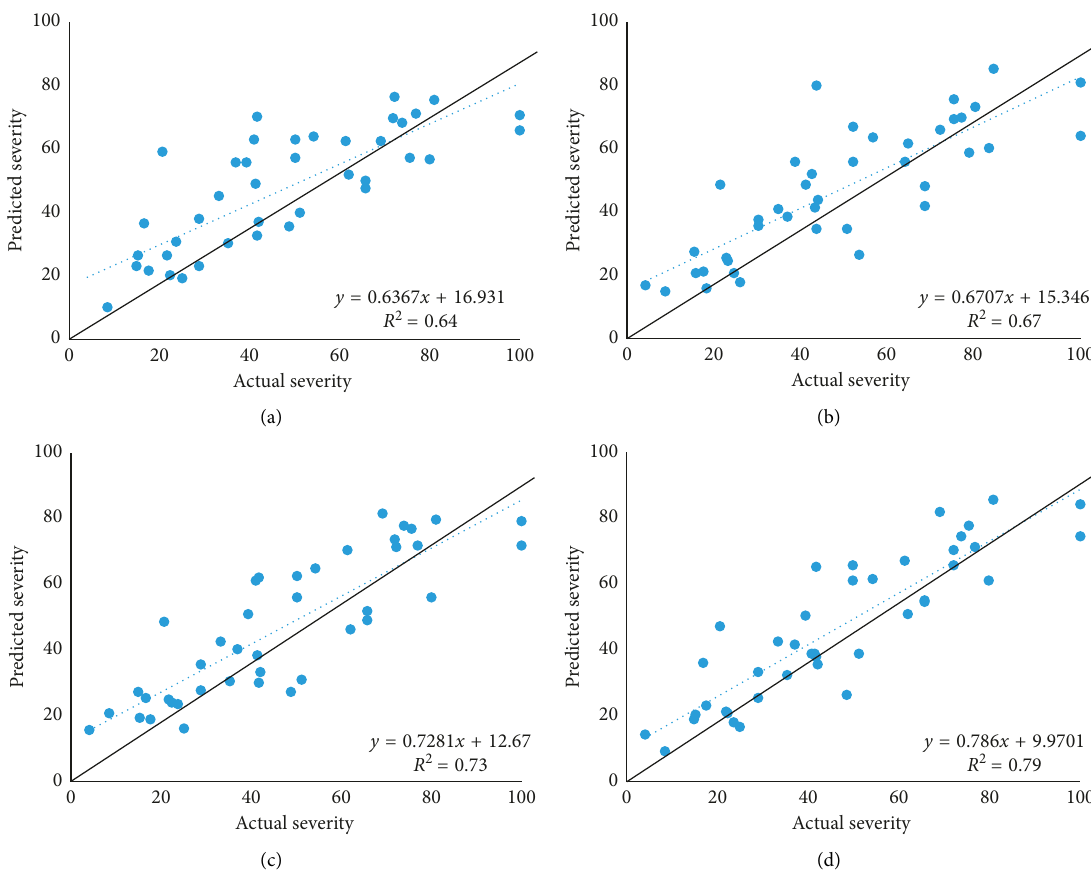
y and disease severities, (b) NBNDVI and disease